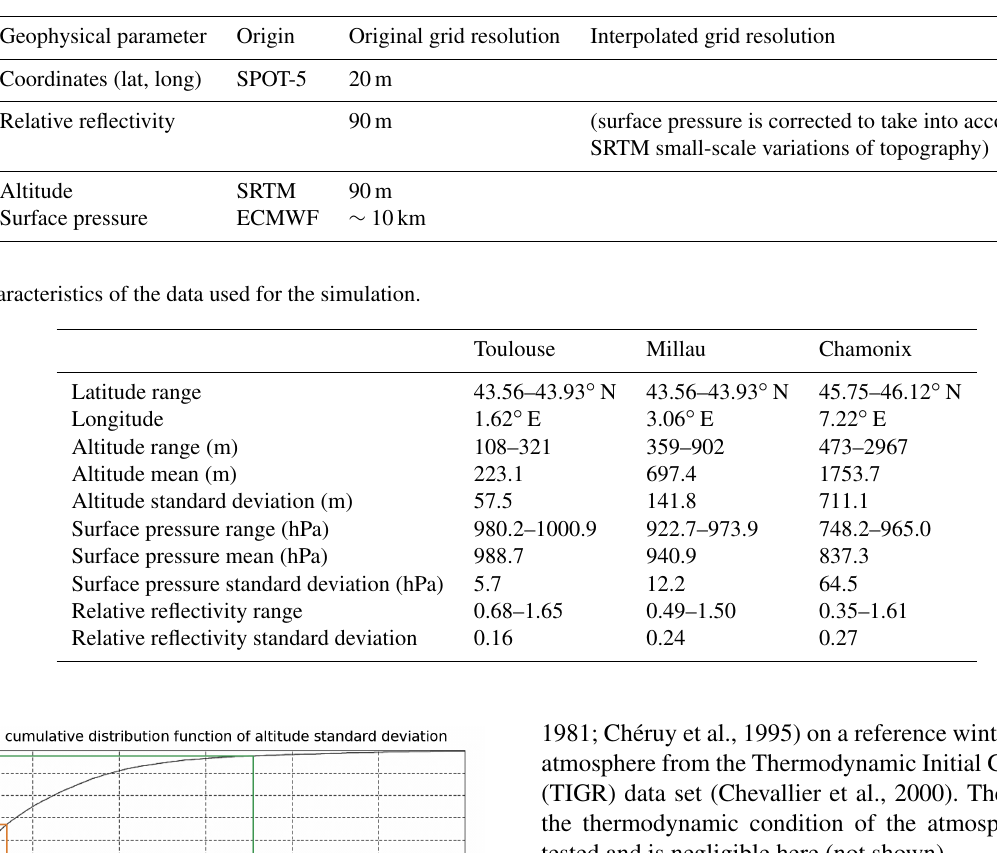
Table 3. Data sets’ resolution characteristics.